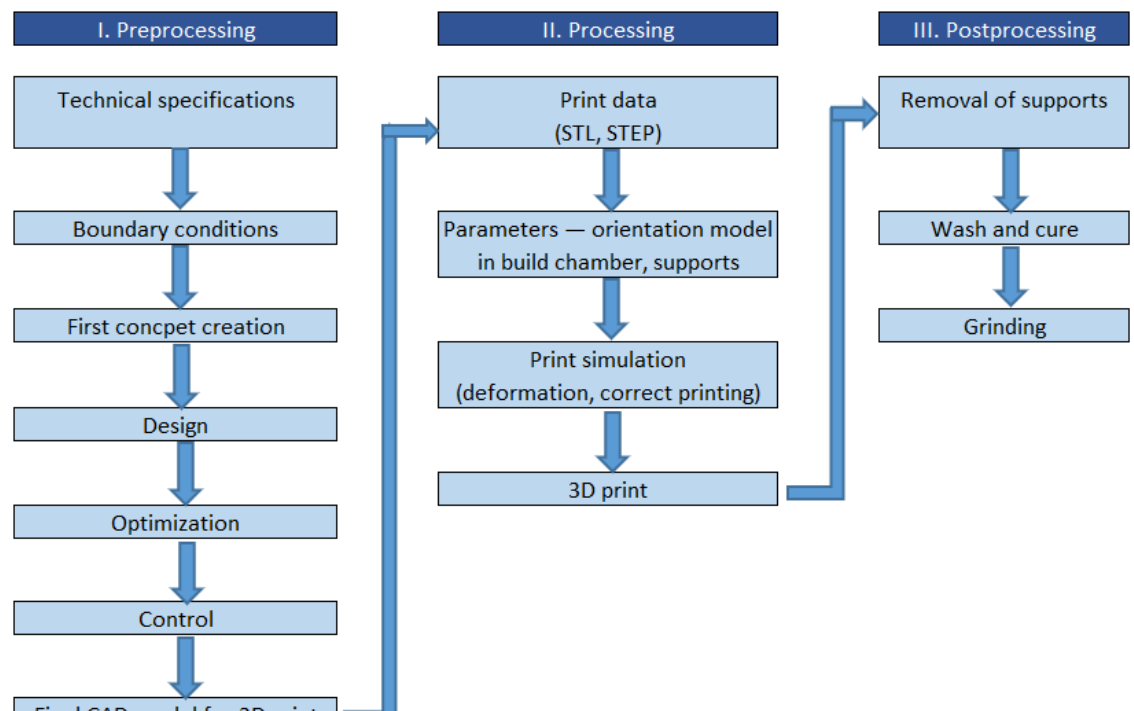
Figure 2. A typical production process with photopolymerization. CAD: computer-aided design, STL: standard triangulation language, STEP: standard for the exchange of product data.